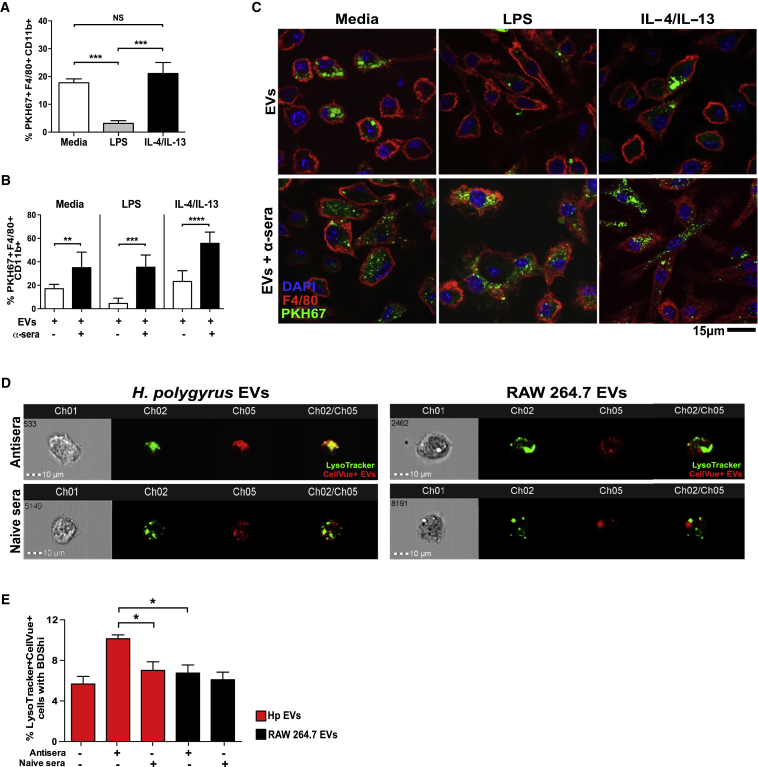
EV Uptake Is Modulated by Macrophage Polarization and the Presence of Specific Antibodies(A) Percentage uptake of 2.5 μg PHK67-EVs into 2.5 × 105 BMDMs that were pre-treated for 24 hr with media alone, 500 ng/mL LPS, or 20 ng/mL IL-4/IL-13, as assessed by flow cytometry using the gating strategy in Figure S1A.(B) Quantification of uptake as in (A) but comparing incubation of PHK67-EVs ± polyclonal EV antisera (1:2,000). Data were analyzed 1 hr after incubation and are presented as mean values ± SD (n = 5–7; one-way ANOVA, ∗p < 0.05, ∗∗p < 0.01, ∗∗∗p < 0.001, and ∗∗∗∗p < 0.0001; NS, not significant).(C) Confocal microscopy of PHK67-labeled EVs incubated with BMDMs as described in (B).(D) Imagestream analysis measuring uptake of 2.5 μg CellVue-labeled H. polygyrus or RAW264/7-derived EVs ± polyclonal parasite-EV antisera or naive rat sera (both 1:2,000). BMDMs incubated with EVs/sera were also stained with LysoTracker Green (n = 5; 10,000 live-cell images taken per replicate).(E) Quantitation of cells showing high co-localization (represented as a measure of bright detail similarity) of LysoTracker with CellVue-labeled EVs in double-positive cells, as determined by IDEAS software. Unless indicated, scale bars represent 15 μm, with representative images shown.